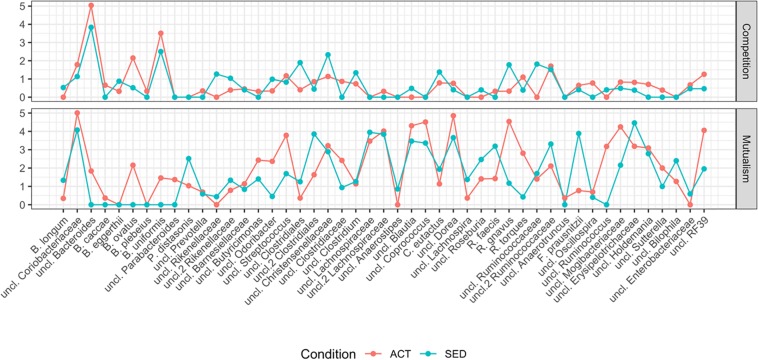
Topological characterization of ACT and SED networks measured by the number of connections (the higher the degree, the more connected the network is) per node (x- axis; full name description in Table 1) for competitiveness (top panel) and mutualism (bottom panel) networks.